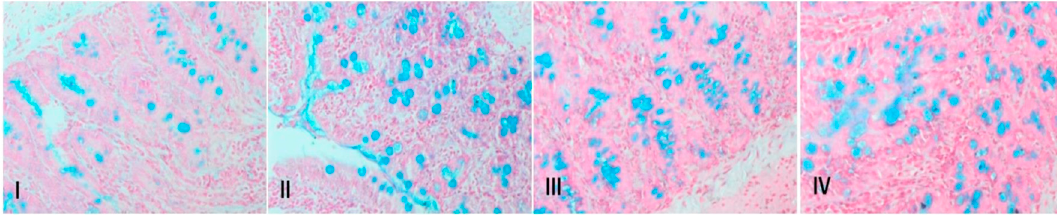
Figure 10. Photomicrographs showing mucin staining. There is decrease in mucin in mucous layer in DMH administered group, which is depicted by blue staining, when compared with control. Treatment with piperine increased mucous layer, as we can see from the lesser appearance of blue staining pattern in III and IV slides, representing groups III and IV ( n = 10).